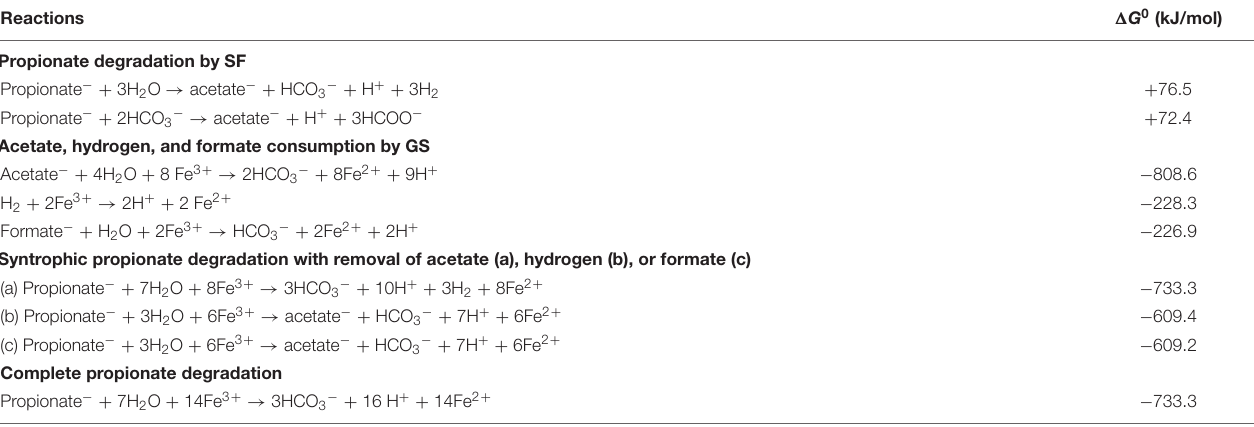
TABLE 1 | Potential reactions during syntrophic growth of SF-GS coculture based on Gibbs free energy changes. Reactions (cid:49) G 0 (kJ/mol) Propionate degradation by